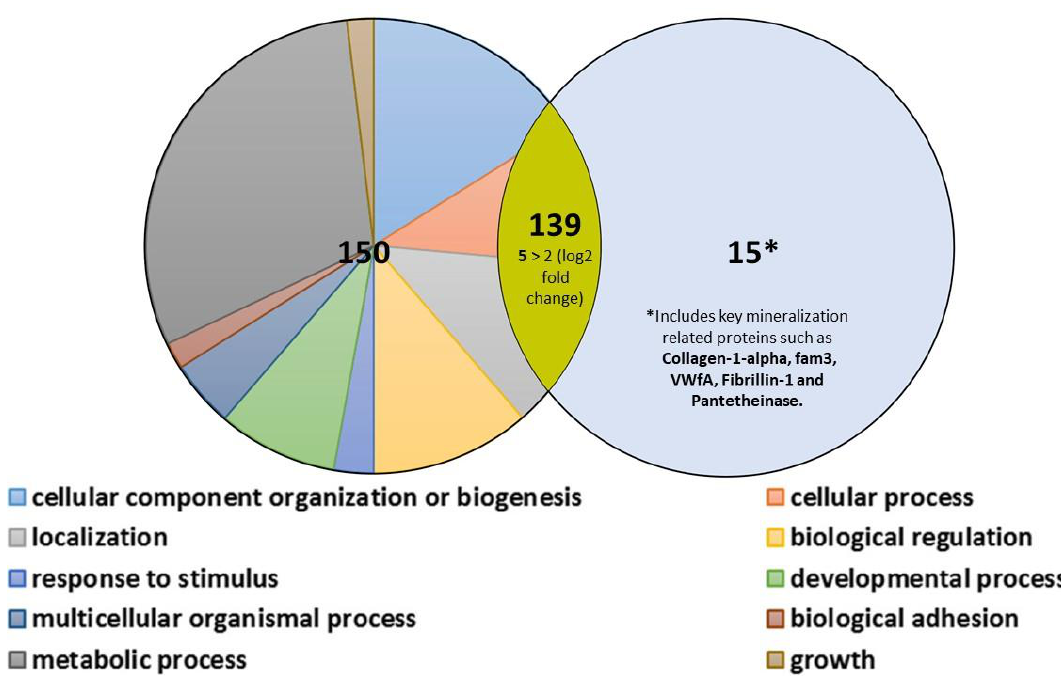
Figure 6. Proteomic signature in MC3T3-E1 and MC3T3-E1-TRIP-1OE matrix vesicles as identified by proteomics analysis. The Venn diagram represents the comparison of the matrix vesicles proteins isolated from MC3T3 ( left ) and MC3T3-TRIP-1OE cells ( right ). In total, 139 proteins were common to both matrix vesicles of which 5 were overexpressed in the vesicles from TRIP-1OE; 15 proteins involved in mineralization were unique to TRIP-1OE cells. Proteins specific to MC3T3 are classed based on their biological process using the PANTHER classification system and depicted in the figure label.